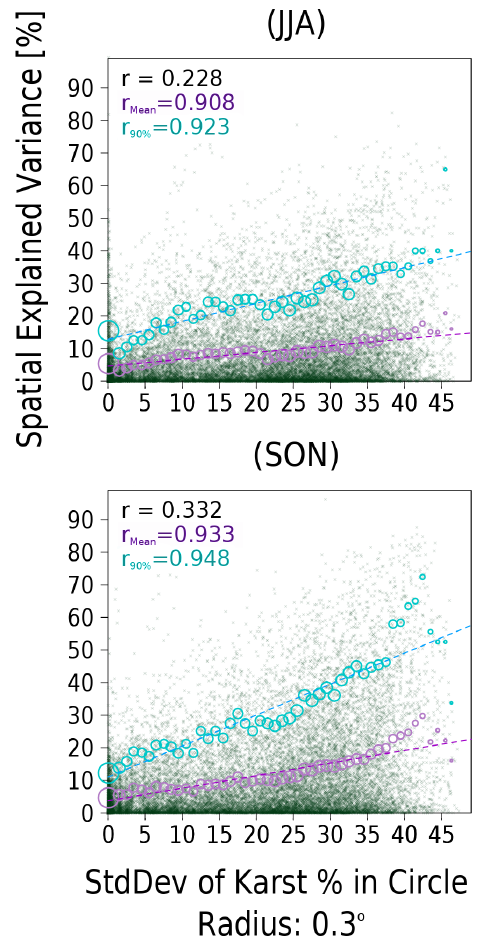
Figure 19. Explained spatial variance in satellite-derived soil moisture memory (e-folding time scale i.e., lag at which the autocorrelation of SMAP soil moisture drops below 1/e) within circles of radius 0.3 ◦ as a function of the standard deviation of gridded United States Geological Survey (USGS) shallow carbonate karst coverage in the corresponding circles. The karst data have been interpolated to the 9 km resolution SMAP Level-3 data grid, and the circles for comparison are centered on each land grid cell between 29–40N, 104–83W. Purple circles indicate the means of spatial explained variance in soil moisture memory within bins of width 2.0% centered on each 1.0% step of the abscissa; cyan circles are for the 90th percentile values. Dotted lines are best-fit linear regressions. All correlations are significant at the 99% confidence